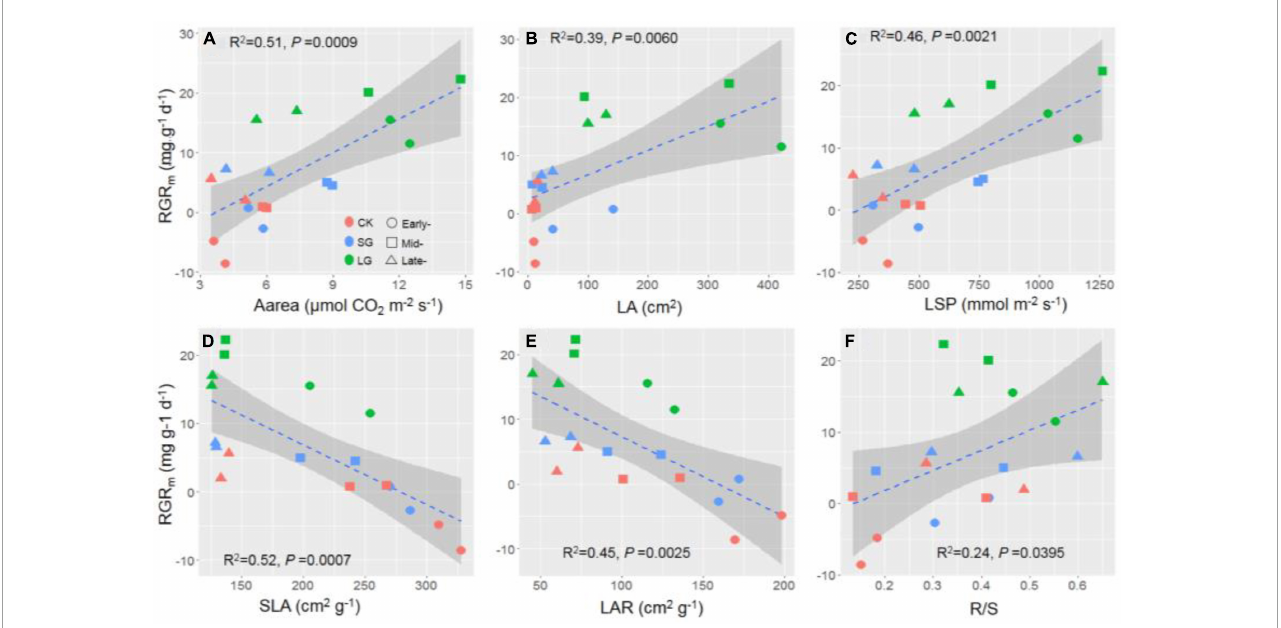
FIGURE4 The relationship between relative mass growth rate (RGR m ) with area- based light saturated rate of CO 2 assimilation [A area , (A) ], leaf area [LA, (B) ], light saturation point [LSP, (C) ], specific leaf area [SLA, (D) ], leaf area ratio [LAR, (E) ], and root: shoot ratio [R/S, (F) ]. The gray shadow represents the 95% confidence interval for the estimates.